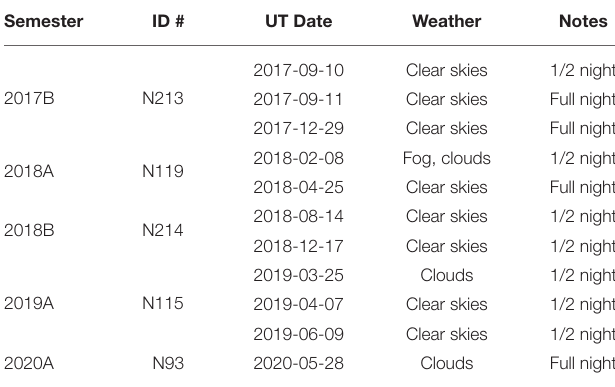
TABLE 1 | NASA Keck observing programs and